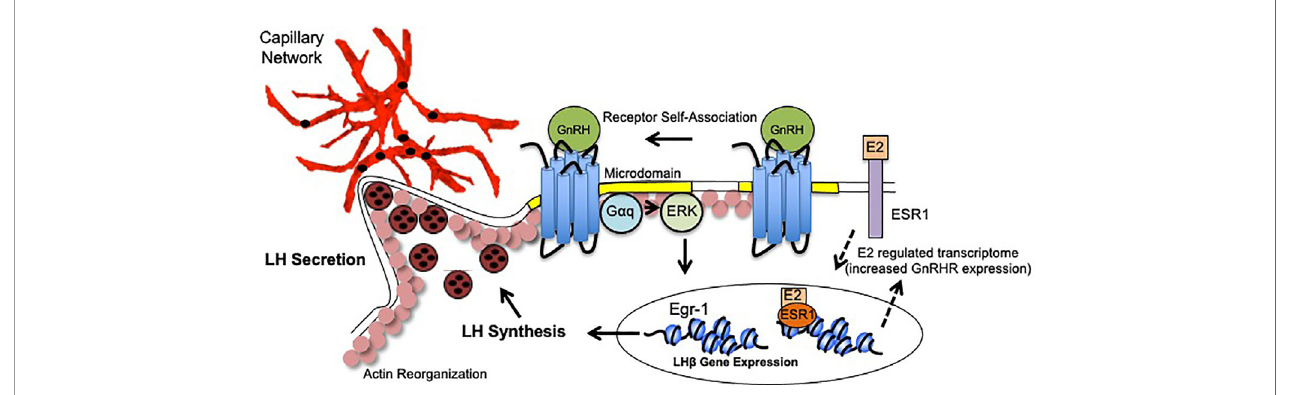
FIGURE 1 | Model of Gonadotrope Dynamics Underlying the LH Surge. During the periovulatory period, ovarian estradiol-17(E2) levels rise. E2 activation of both plasma membrane associated and nuclear ESRI elicits expression of a unique gene program that includes enhanced expression of the GnRH Receptor (GnRHR), and therefore heightened sensitivity to hypothalamic GnRH (dashed arrows). Once expressed, the GnRHR is constitutively localized to microdomains in the plasma membrane (yellow). Following GnRH binding, the GnRHR self-associates to form dimers/oligomers. Second messengers including Gaq/1I and ERK are activated within the microdomains. Increased ERK activity leads to the activation of the immediate early gene Egr-1 which upregulates lhb gene expression. Functional LH is synthesized and packaged into secretory vesicles that embed in the cortical actin cytoskeleton (pink circles). GnRH activation also causes reorganization of the actin cytoskeleton which allows for the gonadotropes to appose the capillary endothelium (red) to release LH into circulation (black